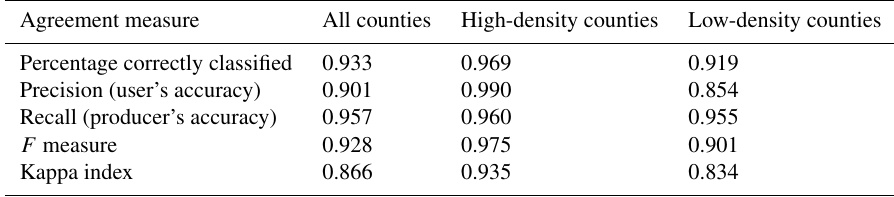
Table F1. Cross comparison of MSBF data against building footprints from integrated 30-counties